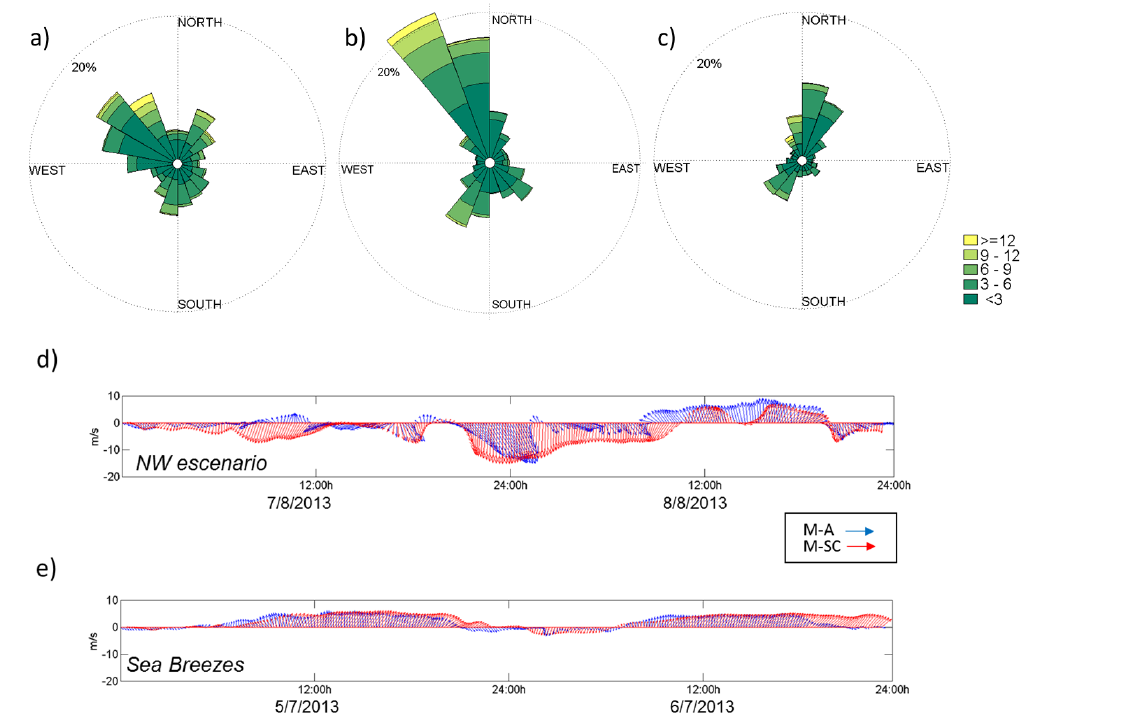
Figure 2. Wind roses for M-A (a) , M-Met (b) and M-SC (c) during the period 2012–2013. Velocities – colour bar in (c) – are in ms − 1 . Dotted line indicates frequency of 20%. Wind time series for northwesterlies and sea breeze events in (d) and (e) , respectively. For (d) and (e) , a Lanczos filter of 2h has been applied to the 10min wind